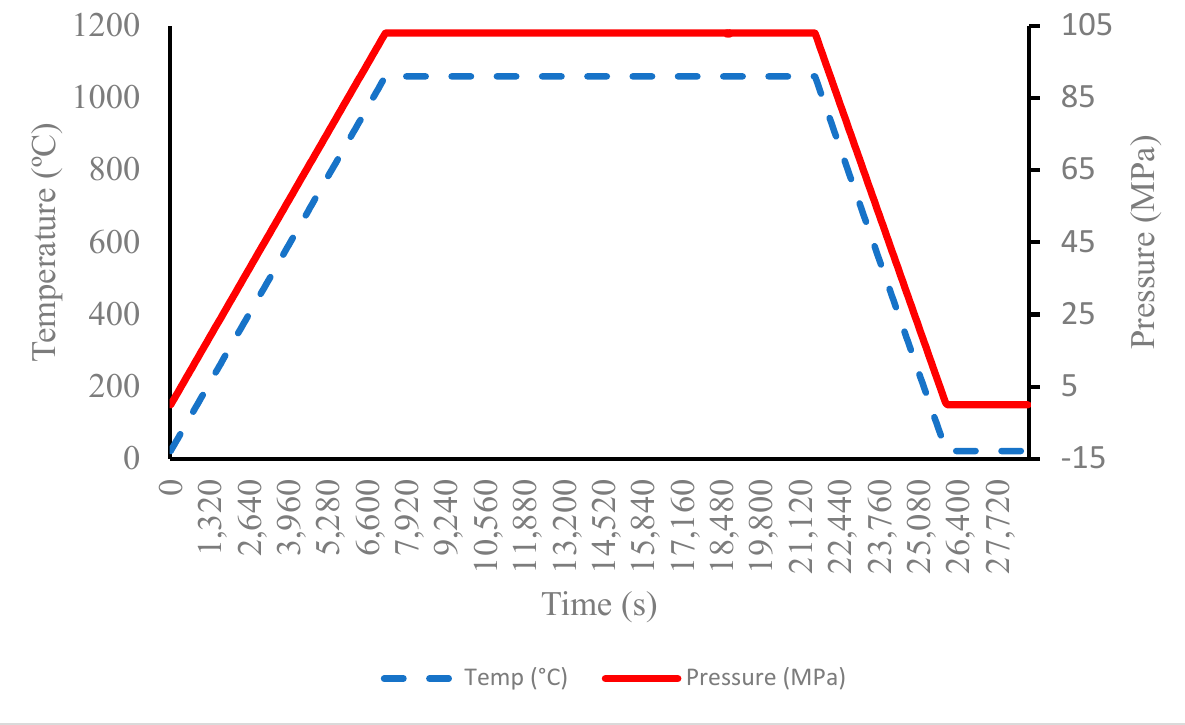
Figure 7. HIP temperature and pressure profiles.